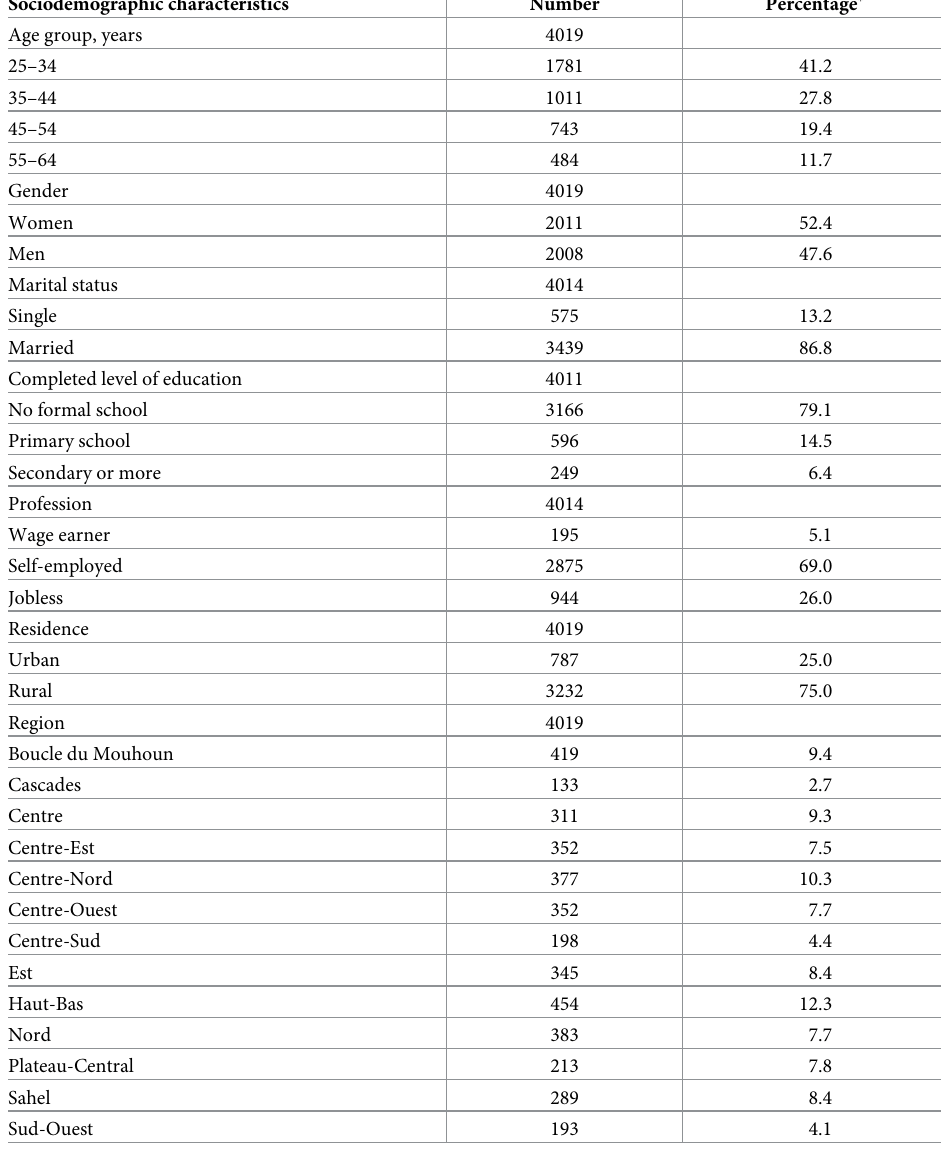
Table 2. Sociodemographic characteristics of the study population. Sociodemographic